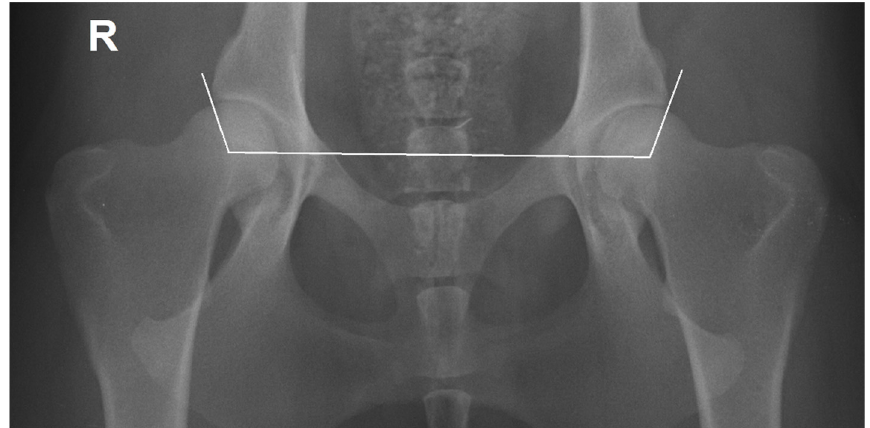
Figure 1. Ventrodorsal hip extended view of a female Transmontano Mastiff with no signs of hip dysplasia, right Norberg angle of 106° (left 110°) and an excellent congruency. The Norberg angle was calculated between the line joining the femoral centres of femoral heads and the other line connecting the centre of the femoral head and the cranial effective acetabular rim. R—right side. The acetabulum and the proximal femur were delimitated using the image polygonal annotation tool (LabelMe version 4.5.13 accessed between 1 January and 31 March 2022) [16]. The acetabular area (AA) and the acetabular area occupied by the femoral head (AAOFH) were measured and the HCI was calculated by dividing AAOFH by AA (Figure 2).